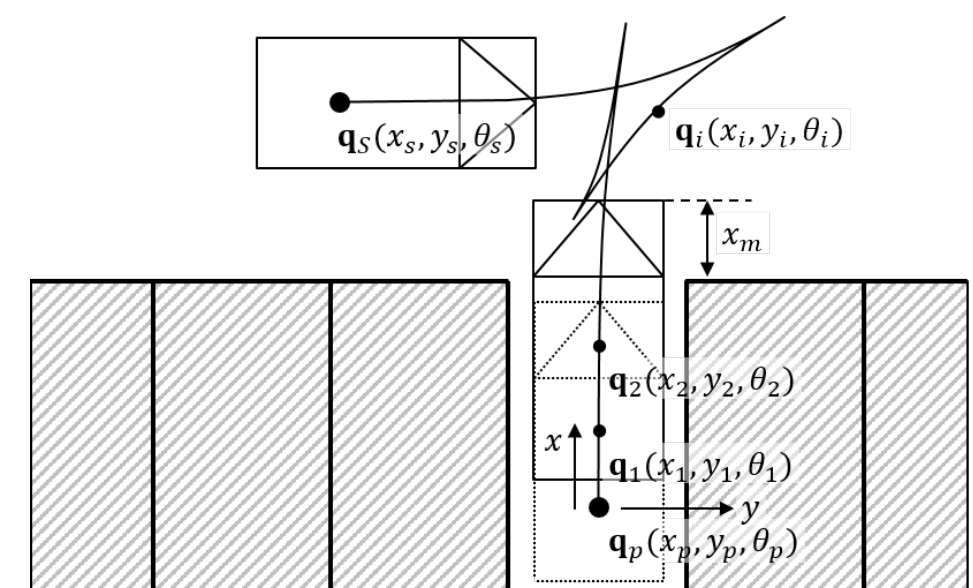
Figure 7. OCP-based parking path planning